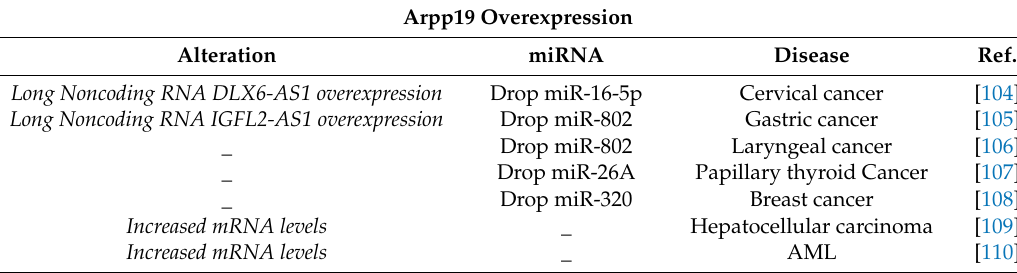
Table 2. Mechanisms triggering Arpp19 overexpression in the indicated types of